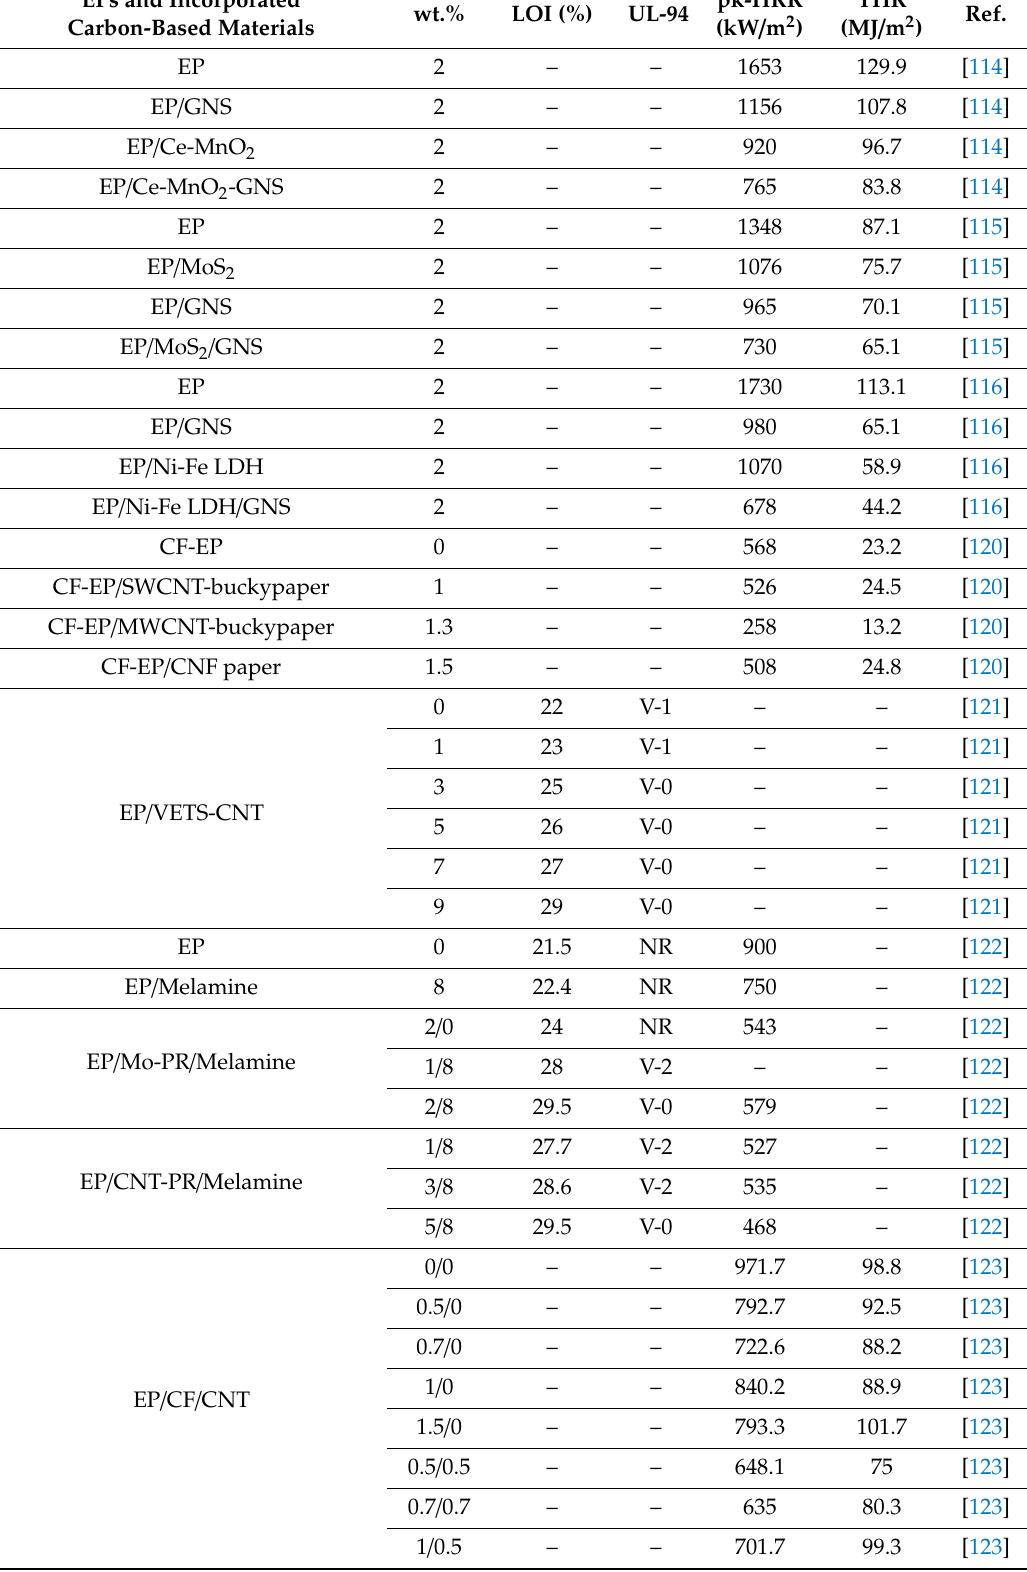
Table 3. The flame retardancy performance of epoxy containing carbon-based materials. EPs and Incorporated Carbon-Based Materials